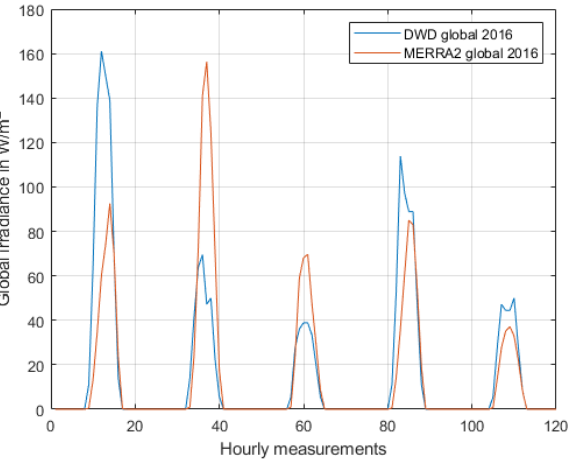
Figure 3. Deutsche Wetterdienst (DWD) and MERRA-2 hourly global irradiance (GI) for 1 January 2016–5 January 2016 in Bremen.